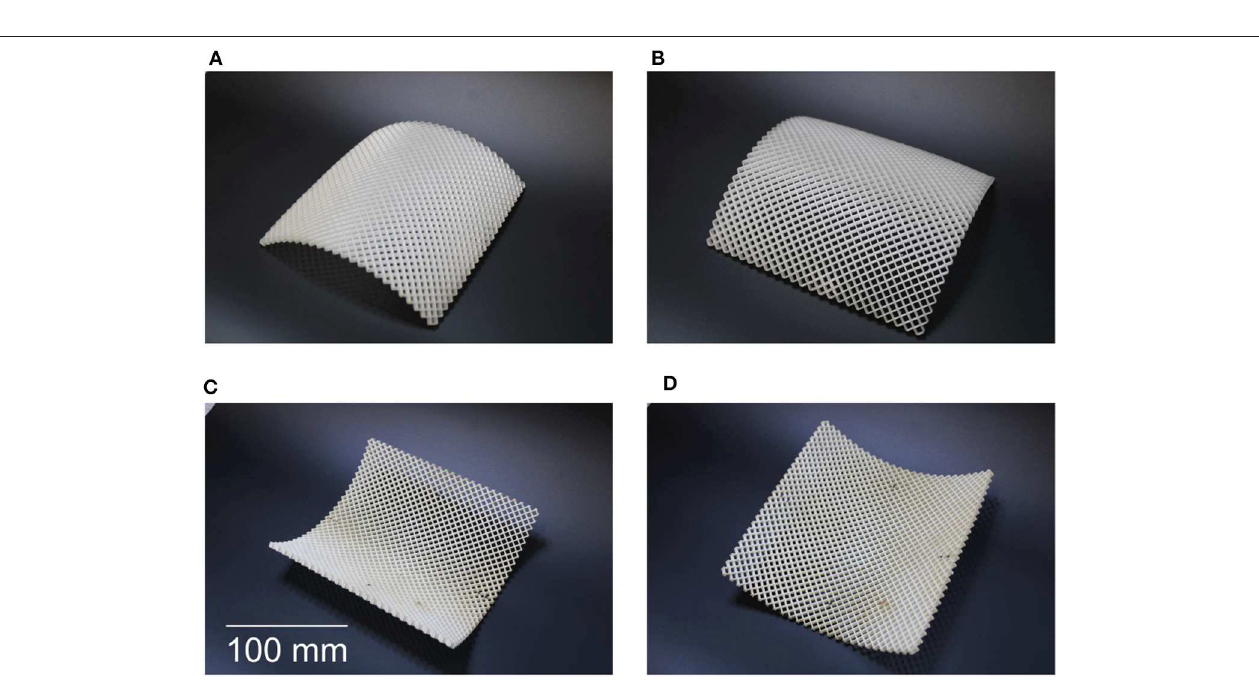
FIGURE 6 | Bistable gridshells made by FDM (top) and SLS of nylon powder (bottom) with the same local and global dimensions. Initial geometries are (A,C) , respectively, with parameters a